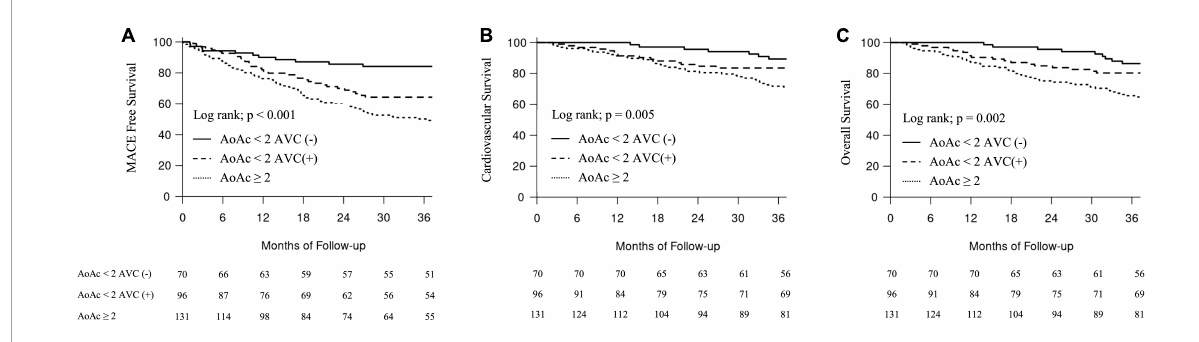
FIGURE2 Major adverse cardiovascular events-free events and survival curves according to groups with different aortic arch calcification (AoAC) severity and aortic valve calcification (AVC). (A) MACE-free events. (B) Cardiovascular survival. (C) Overall survival.